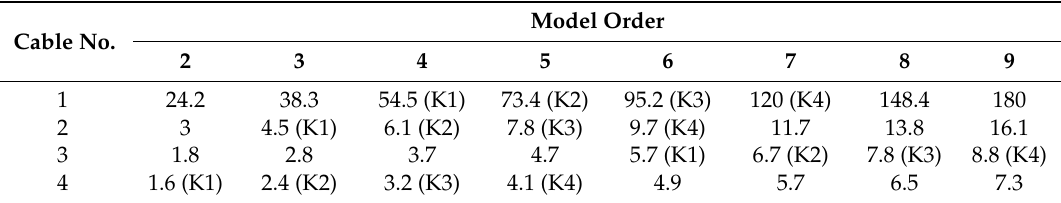
Table 2. Measured frequencies of the simulated